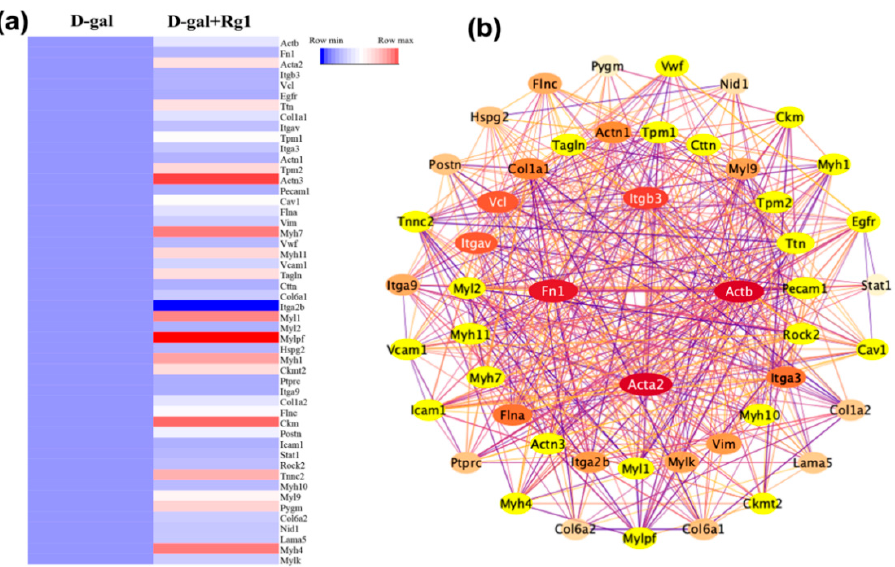
Figure 5. The expression abundance and protein interaction network of key proteins: ( a ) the heat map of the key proteins; ( b ) PPI of key proteins.